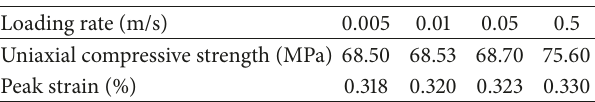
Table 3: Numerical results of the uniaxial compression test under different loading rate conditions.